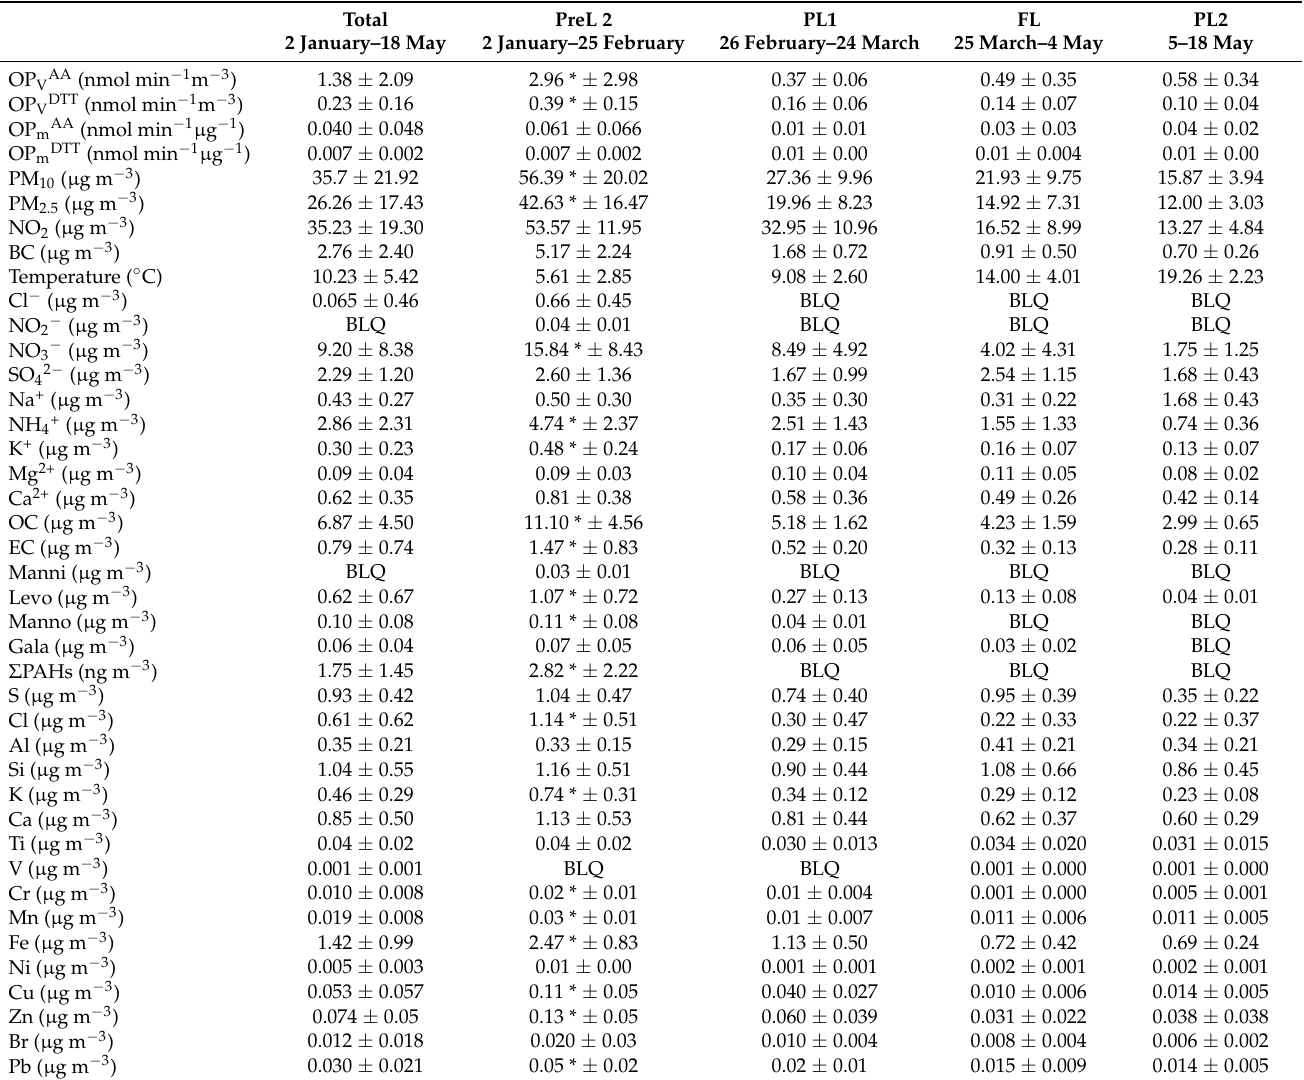
Table 1. OP responses measured with AA and DTT assays, concentrations of atmospheric pollutants (nitrogen dioxide, NO 2 , and black carbon, BC) and of PM 10 chemical components, ambient tem- perature: means and standard deviation values computed for the whole study and each lockdown period. * indicates significant differences (Student t -test. p ≤ 0.05) between the periods. BLQ = below quantification